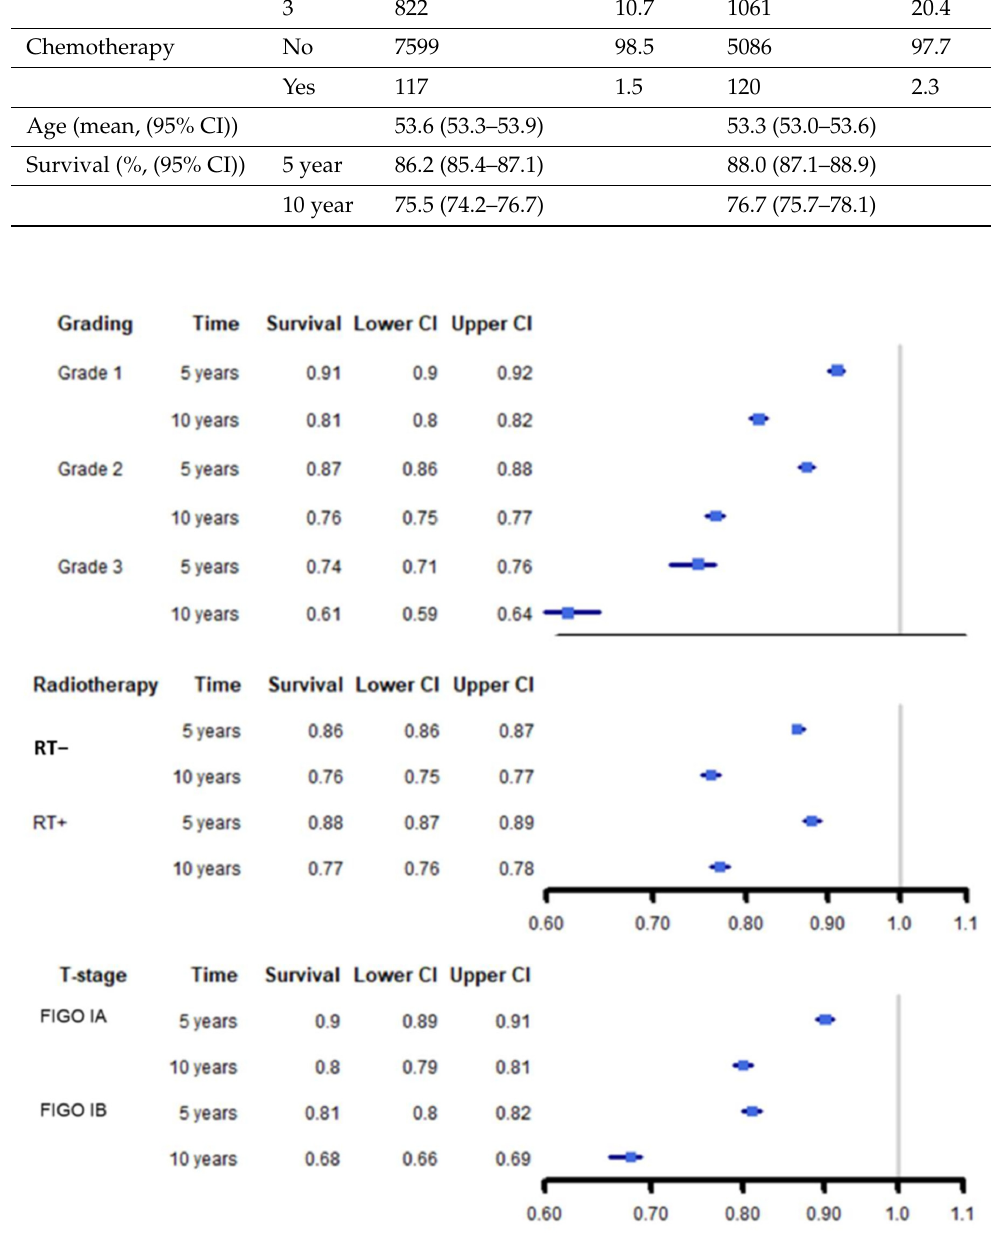
Figure 1. Forest plot on relative survival in relation to the mortality of the general population. Black lines: 95% confidence intervals, blue boxes: E ff ect